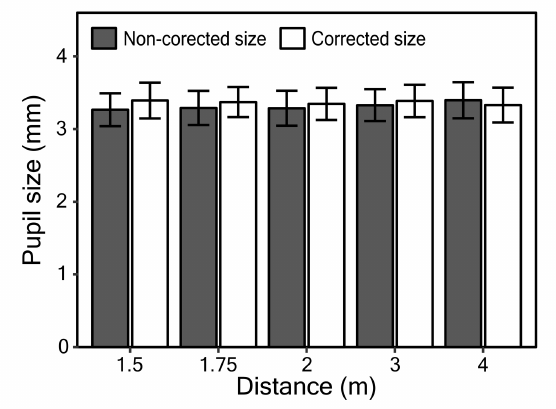
that indicates different magnitudes of pupil constrictions for FN trials and/or pupil dilation for NF trials.